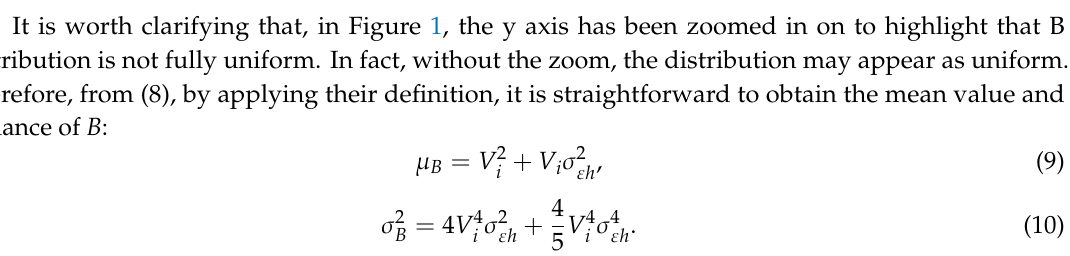
Figure 1. Distribution of 𝐵 with 1 million trials.